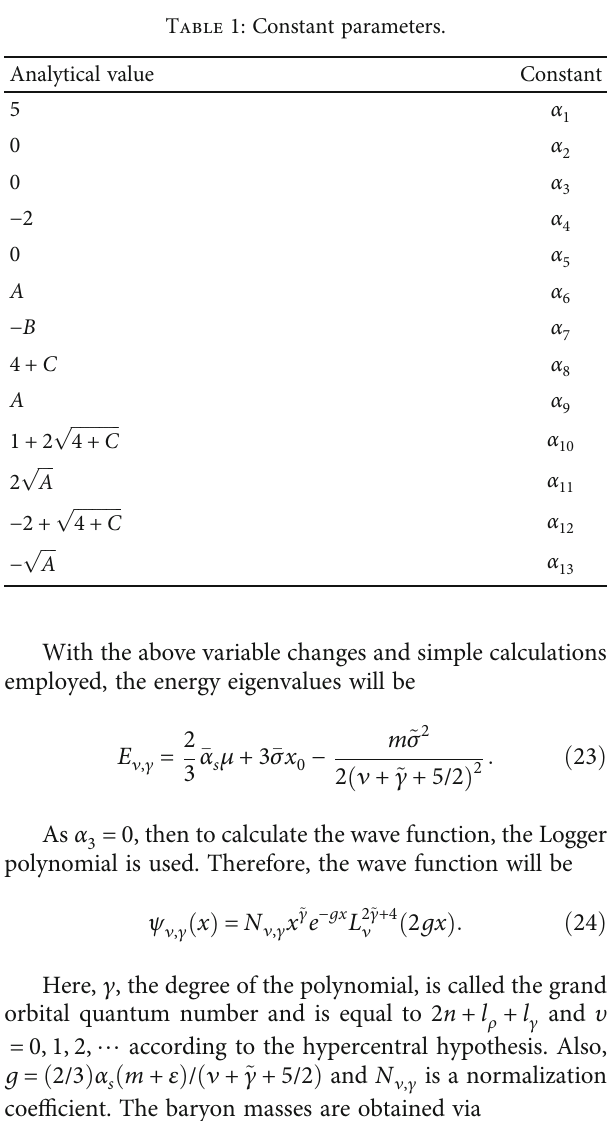
ffiffiffiffiffiffiffiffiffiffiffi p 4 + C